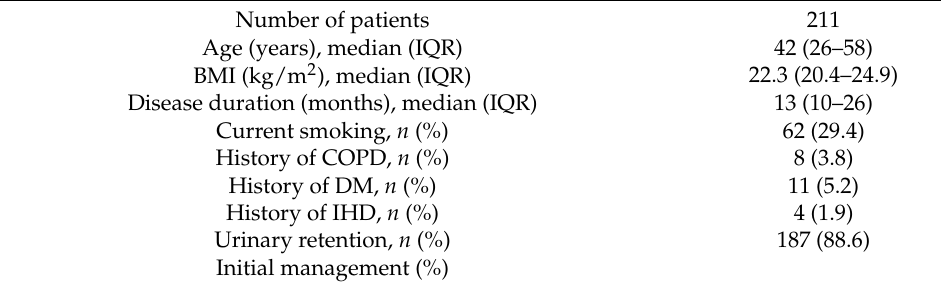
Table 1. Patient